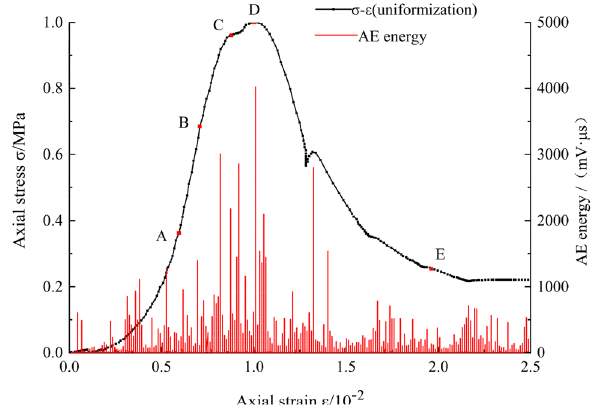
Figure 5. Axial stress and acoustic emission energy plotted against axial strain.